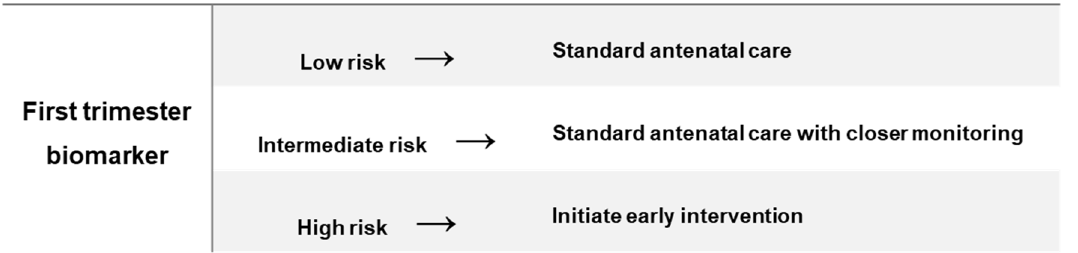
Figure 1. Clinical role of an early biomarker to prevent adverse pregnancy outcomes.